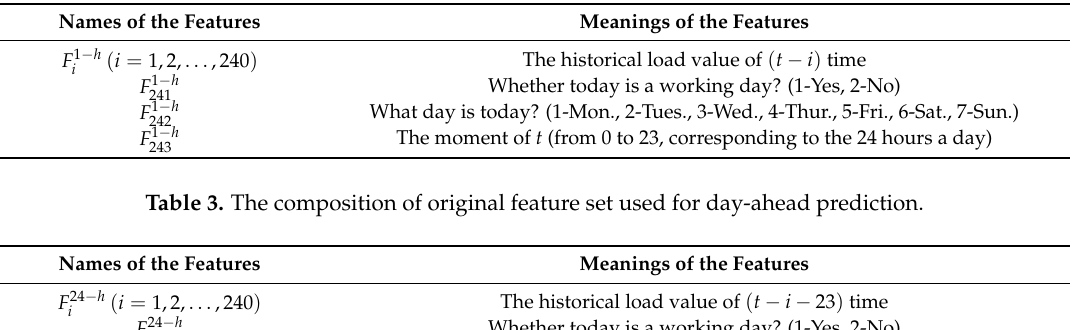
Table 2. The composition of original feature set used for 1 ‐ h ‐ ahead prediction.